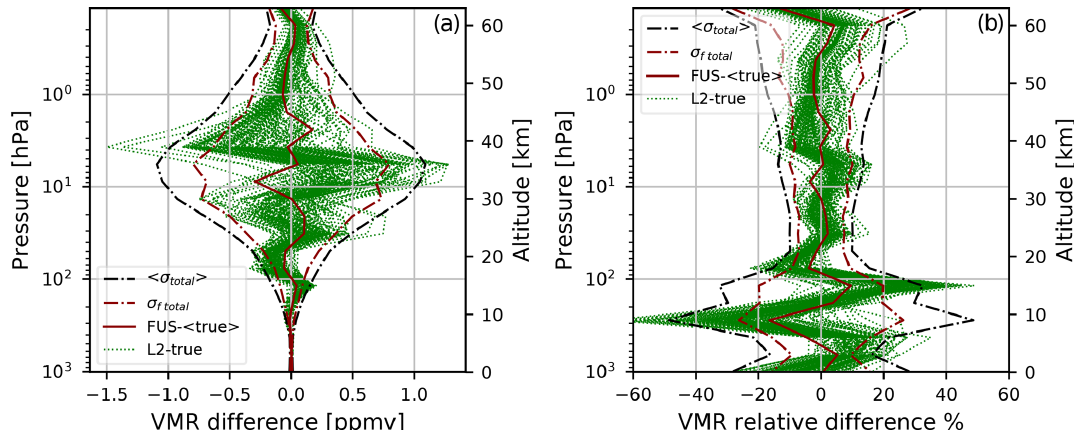
Figure 2. (a) The absolute differences between L2 profiles and their true profiles (green lines), the absolute difference between the fused profile and the average of the true profiles (continuous dark red line), and the average of σ total of L2 simulations (dashed and dotted black lines) and σ f total (dashed and dotted dark red lines). (b) The relative percentage differences between L2 profiles and their true profiles (green lines), the relative percentage difference between the fused profile and the average of the true profiles (continuous dark red line), the average of σ total of L2 simulations normalized with respect to the true profile and expressed in percentage (dashed and dotted black lines), and σ f total normalized with respect to the true profile and expressed in percentage (dashed and dotted dark red lines).